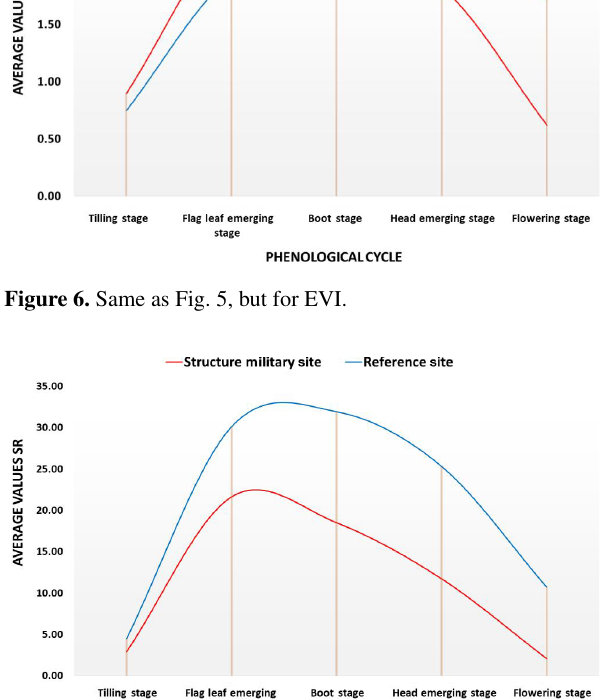
Table 3. Average Values of Vegetation Indices for the Structure Mil- itary Site (SMS) and Reference Site (RS) during the tilling stage. Vegetation SMS average RS average